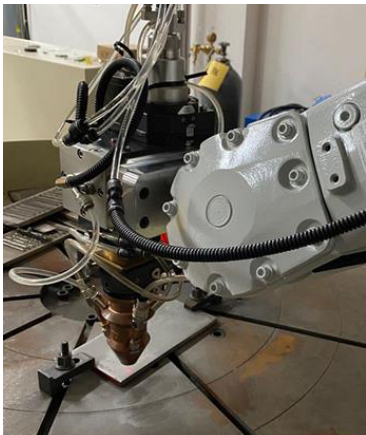
Figure 3. Experiment equipment of coaxial powder feeding laser deposition.